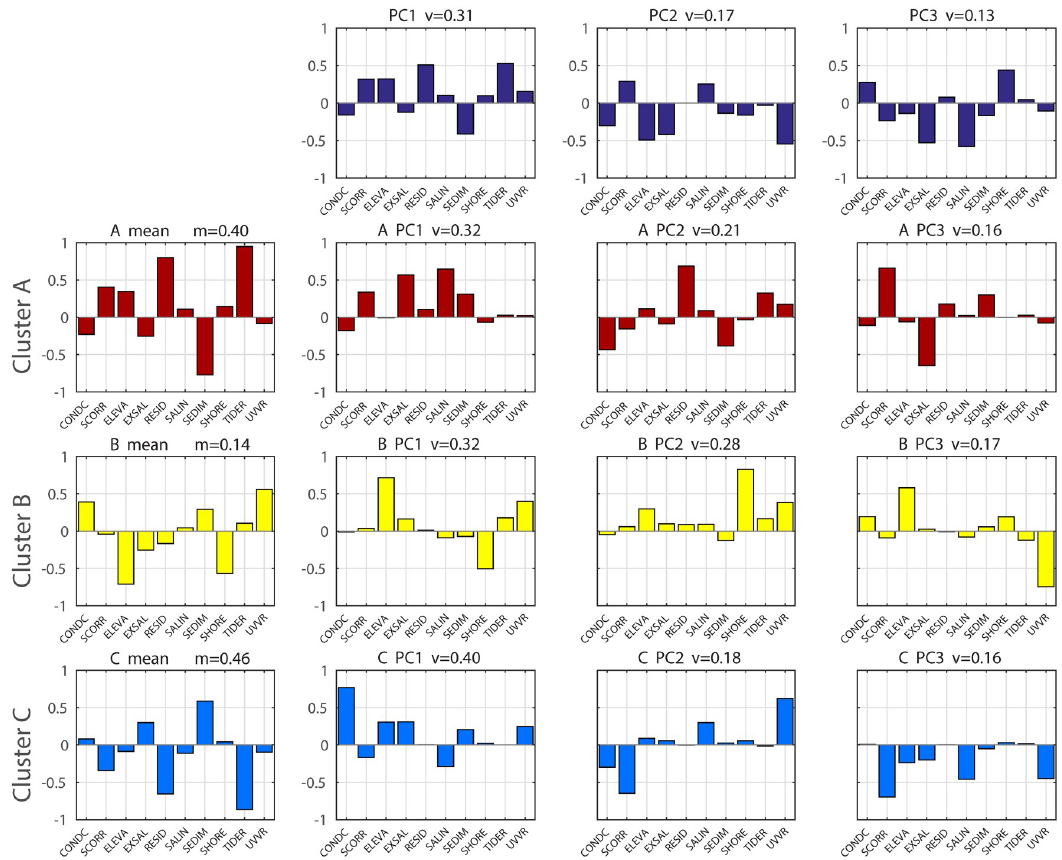
Fig 7. PCA analysis of the entire dataset and the three different clusters obtained using Expectation-Maximization to separate the components. First row: PCs of the entire dataset without cluster separation. Second row: Means and PCs of Cluster A (BBLEH interior). Third row: Means and PCs of Cluster B (inlet influence). Fourth row: Means and PCs of Cluster C (Great Bay). v is the fraction of total variance explained by that PC component. m is fraction of total marsh units included in each